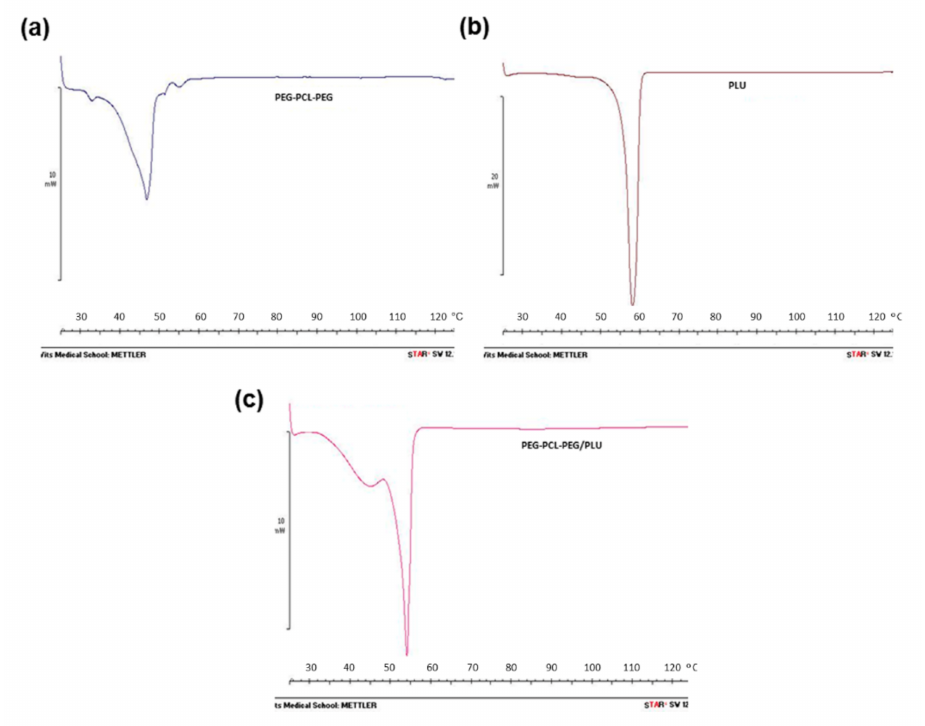
Figure 5. DSC (differential scanning calorimetry) thermograms of synthesised and lyophilised hydrogels ( a ) PEG-PCL-PEG, ( b ) Pluronic and ( c )